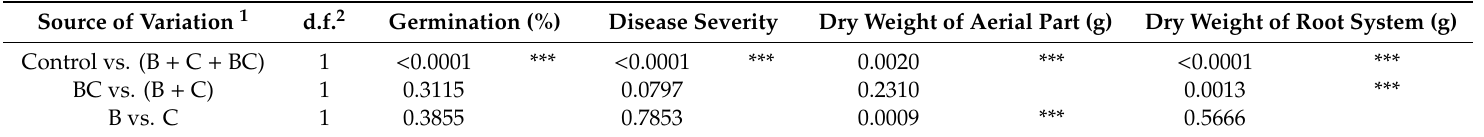
Table 3. Orthogonal contrast for additives in the parameters germination, disease severity 45 after sowing, and dry weights of aerial part and root system. Source of Variation